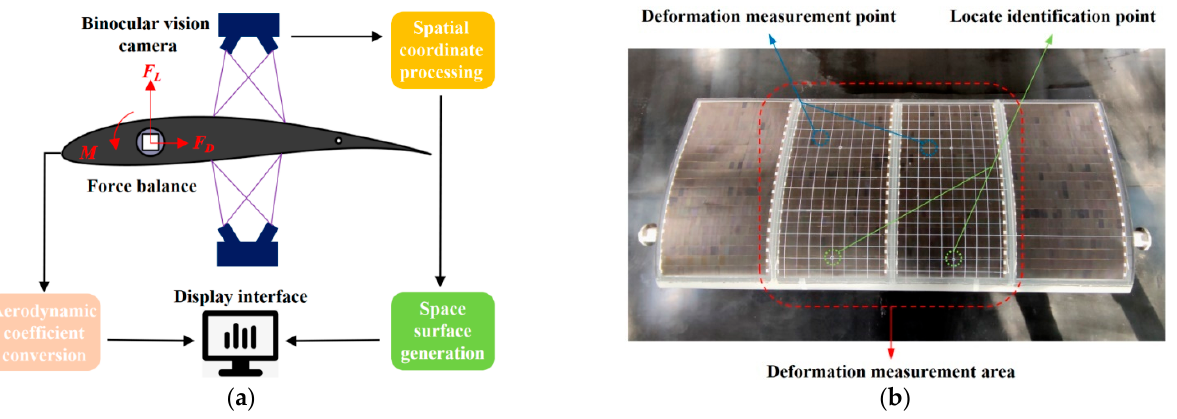
Figure 6. Membrane deformation measurement method: ( a ) Deformation-measurement mechanism; ( b ) Deformation measurement points on the membrane.